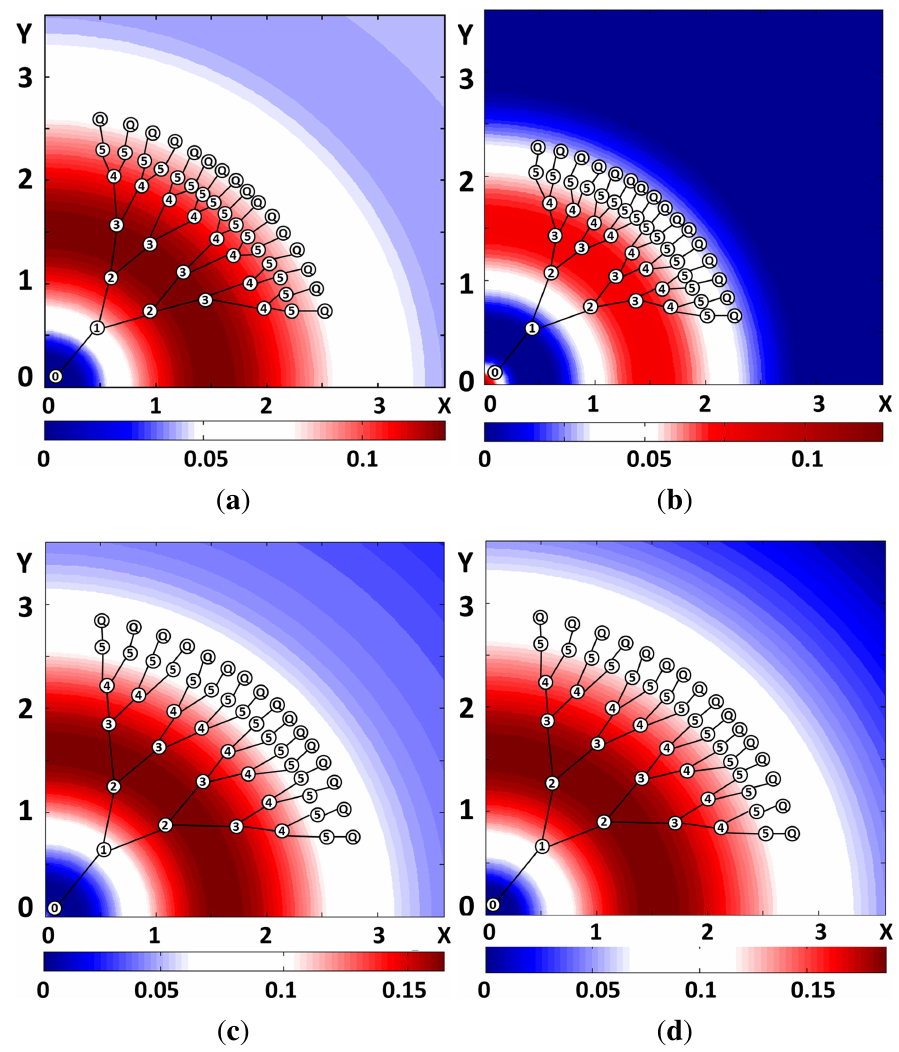
Figure 6. Two-dimensional probability distribution function, P(r), of Phe molecules from the core of each dendrimer. The white circles indicate the branch points of the dendrimers. The numbers in the circles represent the generation of the dendrimer, and Q is the abbreviation for Q . The color bars express the intensity of P(r). The unit of X d and Y axis is nm. ( a ) Atomistic simulation; ( b ) solvent free coarse-grained; ( c ) explicit solvent coarse-grained (27 dendrimers); ( d ) explicit solvent coarse-grained (216 dendrimers) Reprinted with permission from [49]. Copyright 2011 by the American Physical